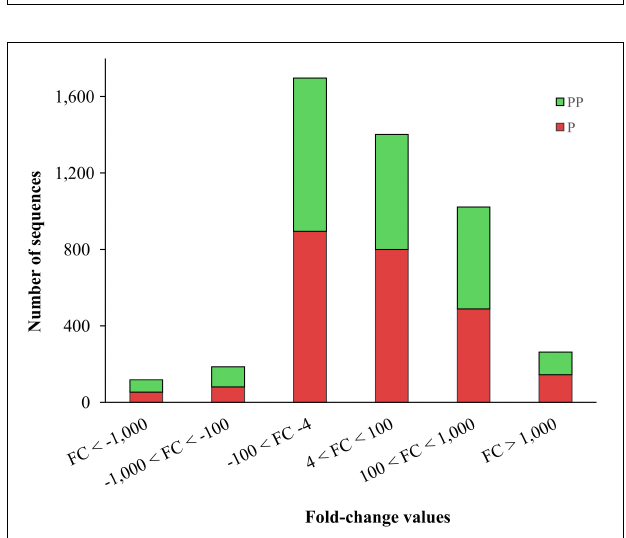
FIGURE 4 | Fold change of differentially expressed genes of Diatraea saccharalis larvae parasitized (P) or pseudoparasitized (PP) by Cotesia